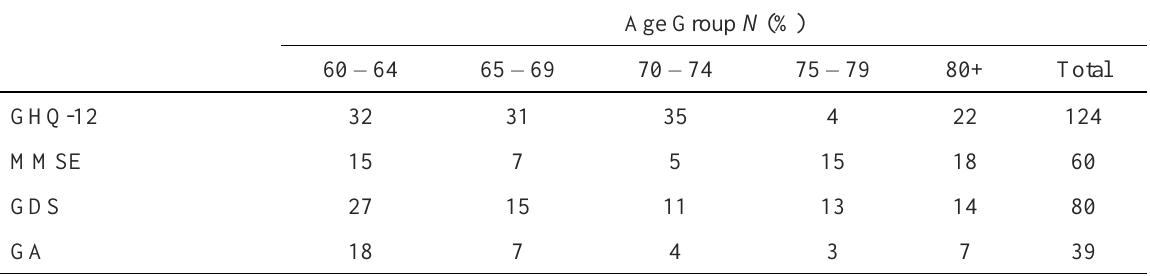
Table 3: Participants who screened positive for psychiatric disorders stratified by age